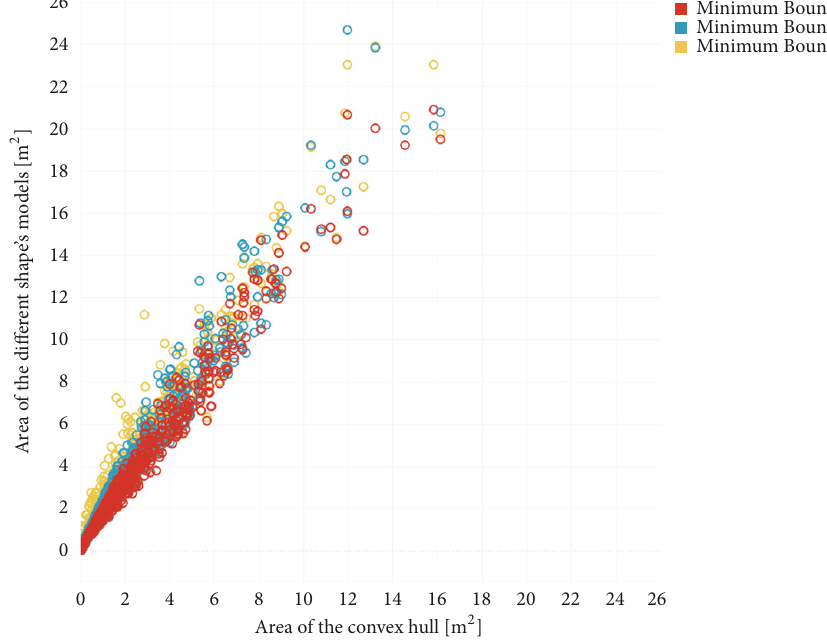
Figure 4: Plotting the different models versus the convex